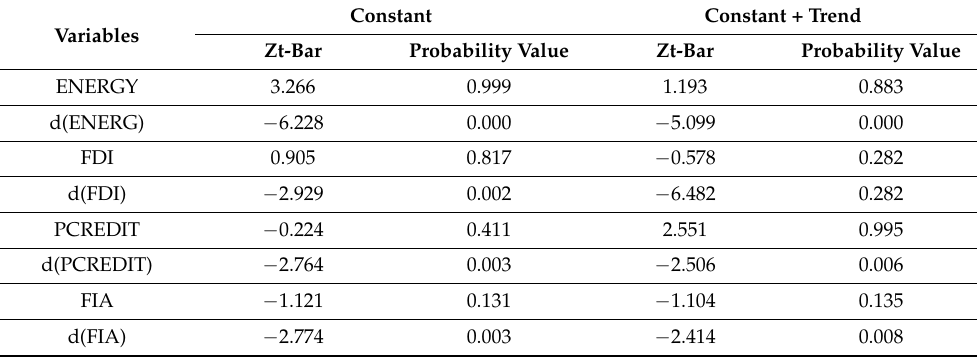
Table 5. Unit root test.